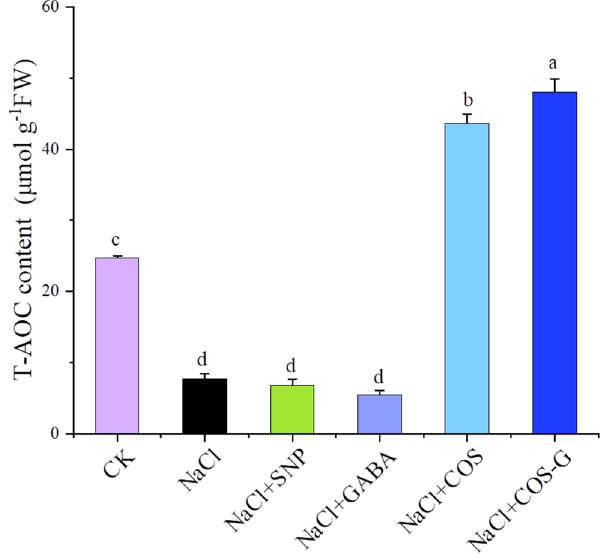
Figure 8. Effects of different treatment groups on T-AOC in wheat seedling leaves under salt stress. Values are the mean ± SD of three replicates in independent experiments. Different letters ( a,b,c,d ) indicate significant differences at p < 0.05 on the same parameter.